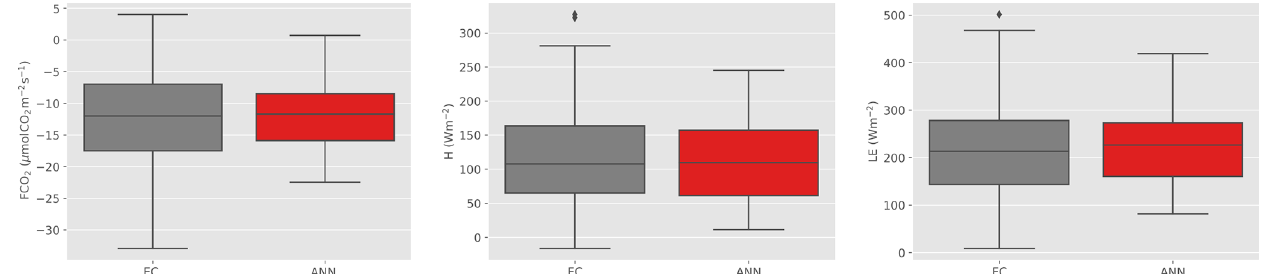
Figure 3. Box and whisker plots with extreme data points added for the diurnal cycle of FCO 2 (µmolCO 2 m − 2 s − 1 ), H (Wm − 2 ), and LE (Wm − 2 ) calculated from flux tower data through eddy covariance (EC) (gray) and modeled by ANNs (red) for 6d (23, 24, 25 and 29 August and 1 and 10 September) over the dry season of 2007 in Rebio Jaru. The height of the box portion is given by the interquartile range of the dataset and extends from the 25th to 75th percentile. The horizontal bar within the box denotes the median value. The ends of the whiskers are drawn to the10th and 90th percentile values. The extreme values are points at the maximum and